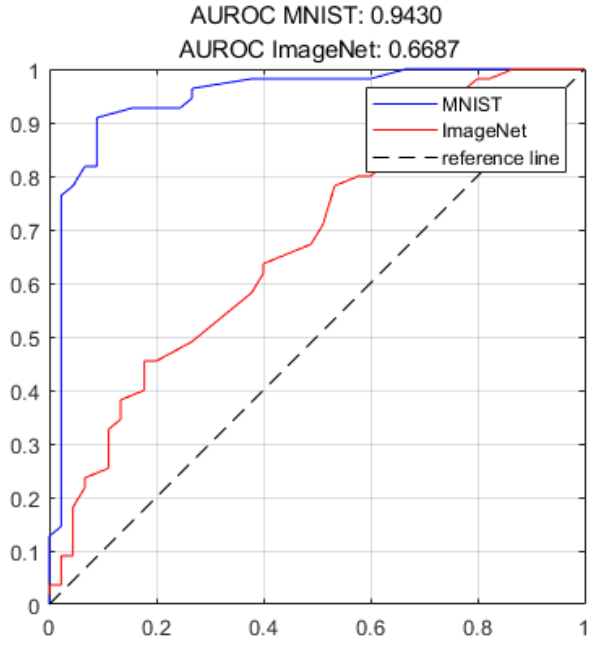
Figure 5. Area under the ROC curve of the watermarked